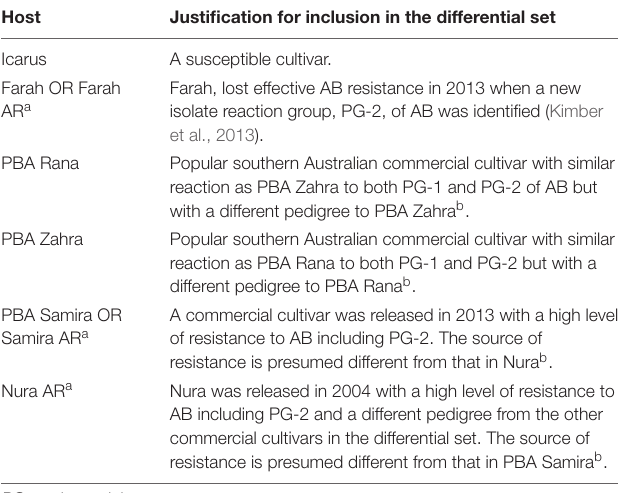
TABLE 1 | Faba bean host differential cultivars or selections used in annual pathogenicity testing and the justification for their